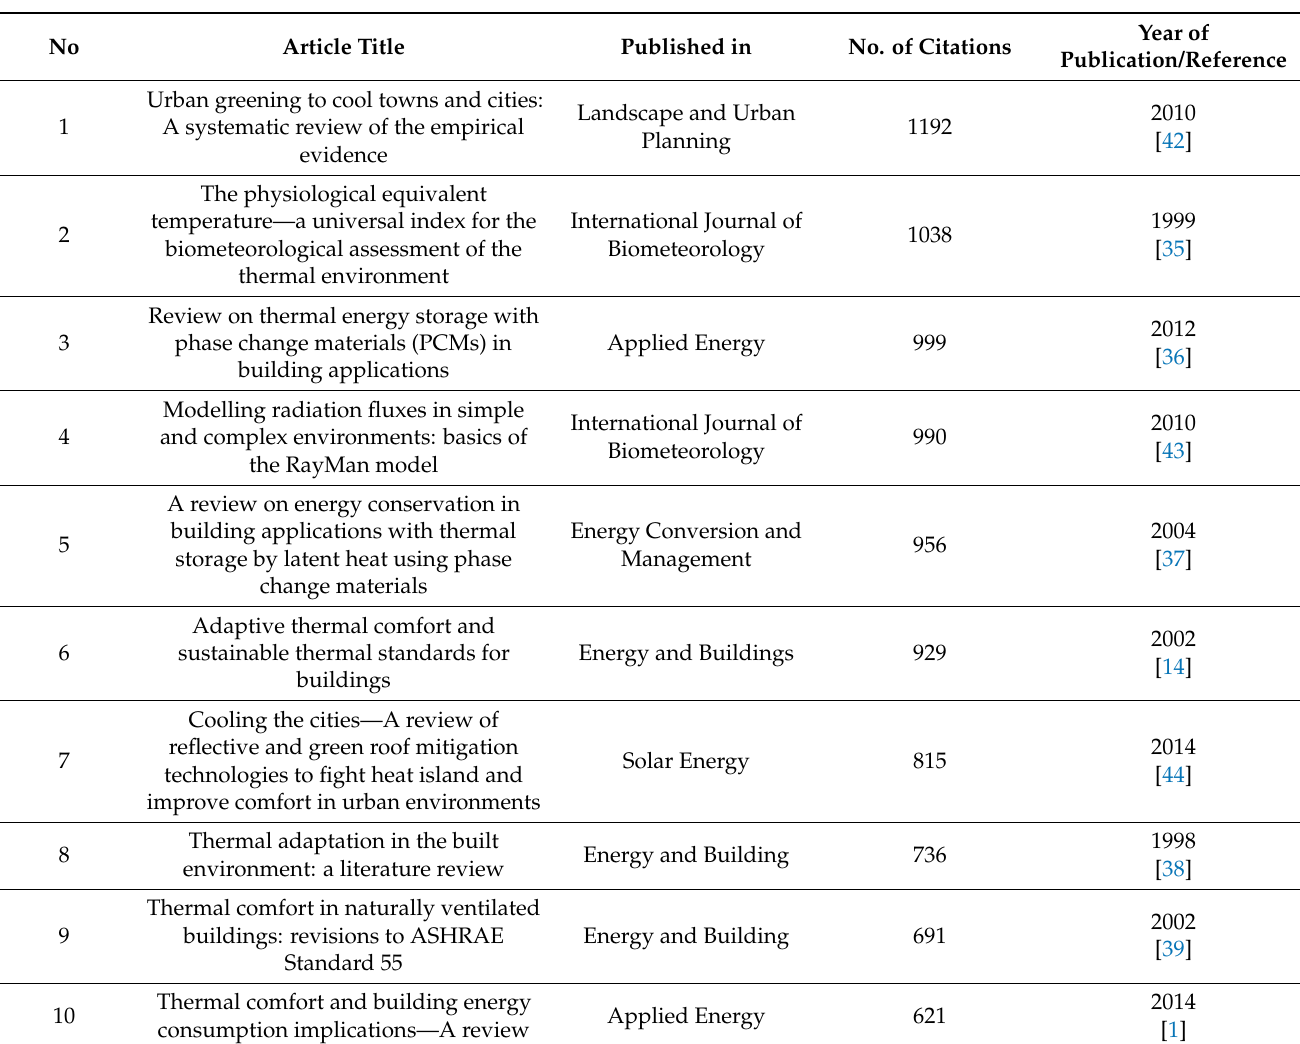
Table 3. Top 10 documents regarding thermal comfort found in WOS based on the number of